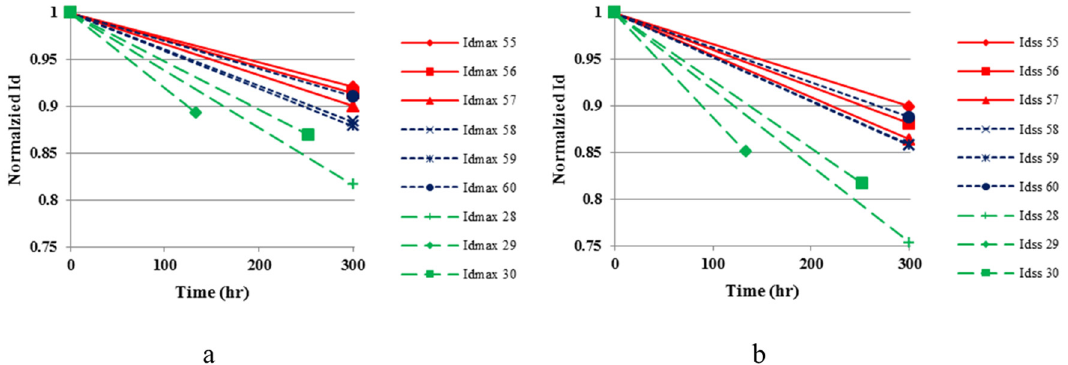
Figure 1. Normalized (to the 0 h measurements) pre- and post- stress values of ( a ) maximum drain current ( I Dmax ) and ( b ) steady state drain current ( I DSS )for the 300 h high-power conditions. The top three lines (red) of the legend are Condition 1, the middle three (blue) Condition 2, and the bottom three (green) Condition 3.